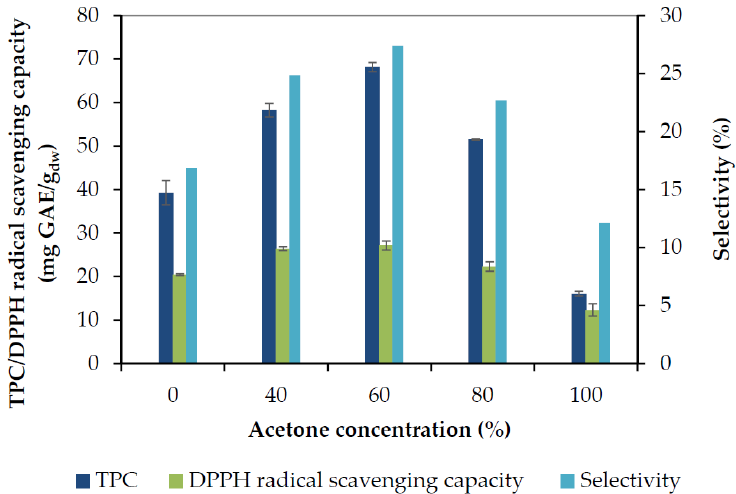
Figure 4. The effect of acetone concentration on total phenol recovery (TPC), DPPH radical scavenging capacity, and selectivity, obtained after 70 min of extraction.